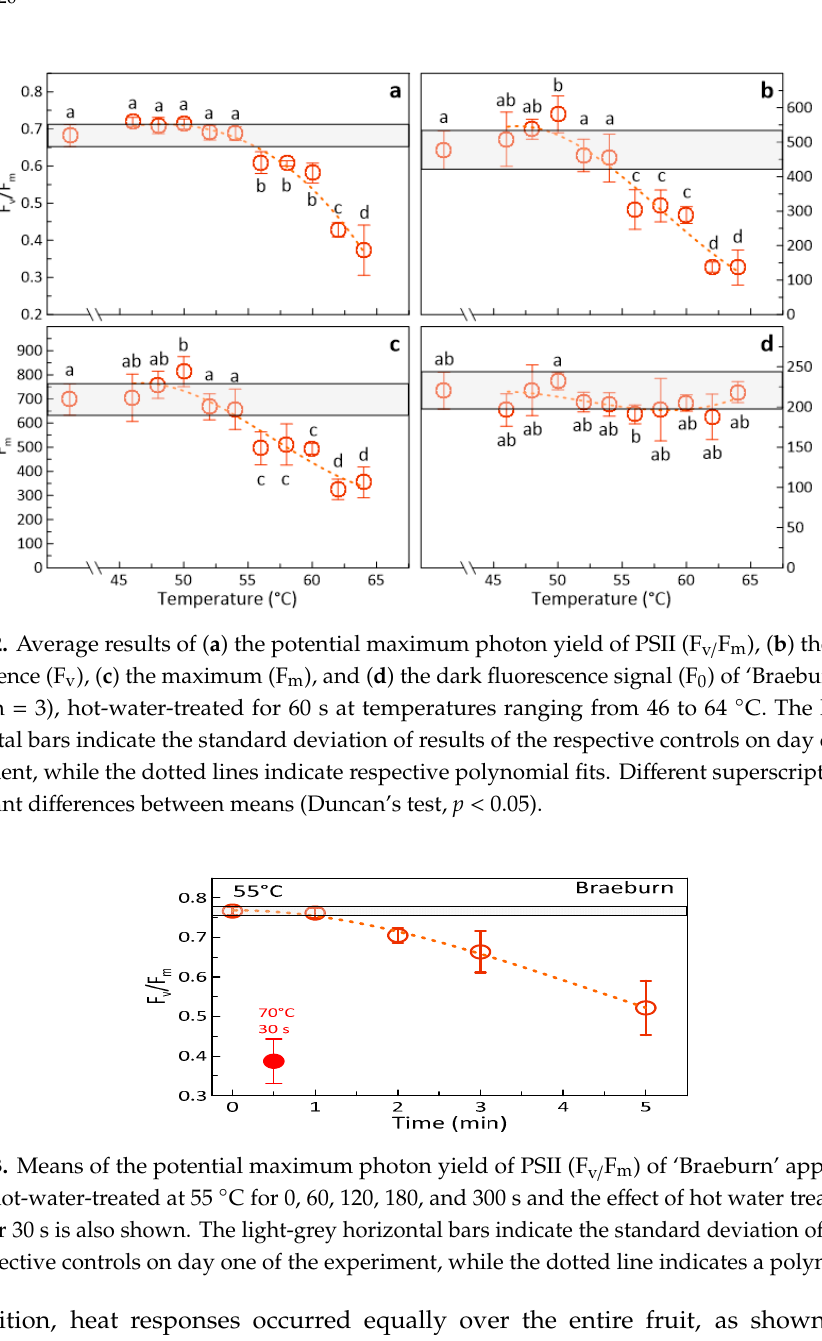
Figure 3. Means of the potential maximum photon yield of PSII (F v/ F m ) of ‘Braeburn’ apples (± SD; n = 3), hot ‐ water ‐ treated at 55 °C for 0, 60, 120, 180, and 300 s and the effect of hot water treatments at 70 °C for 30 s is also shown. The light ‐ grey horizontal bars indicate the standard deviation of results of the respective controls on day one of the experiment, while the dotted line indicates a polynomial fit.